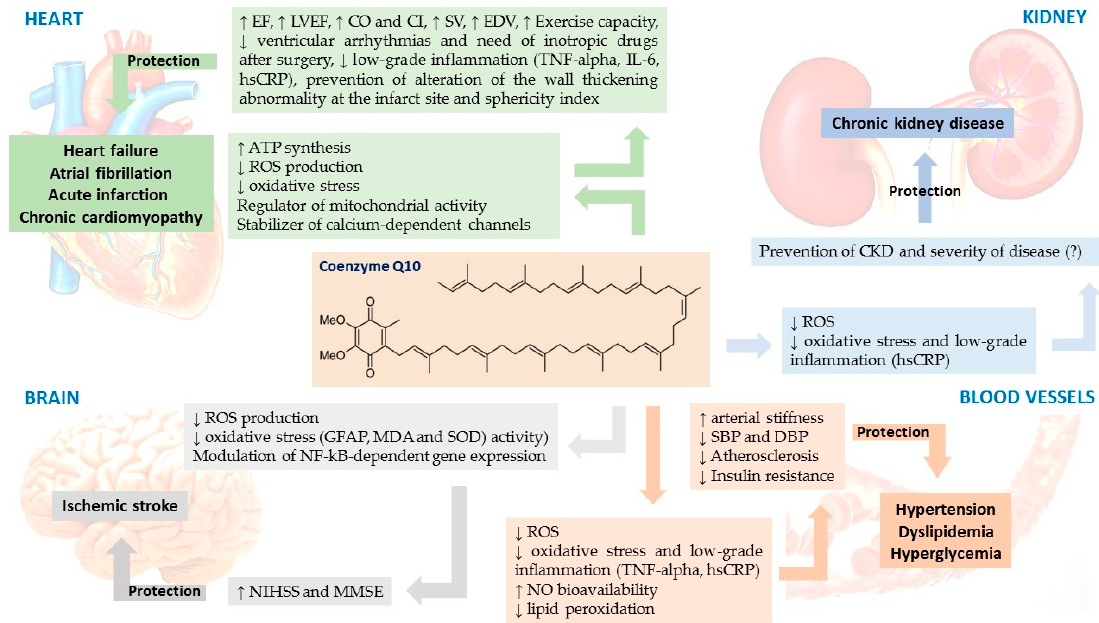
Figure 2. Involvement of CoQ 10 deficiency and cardiovascular disease risk factors. ATP: adenosine triphosphate; CI: cardiac input; CO: cardiac output; CKD: chronic kidney disease; DBP: diastolic blood pressure; EDV: end-diastolic volume; EF: ejection fraction; GFAP: glial fibrillary acidic protein; hs-CRP: high sensible- C reactive protein; IL-6: interleukin-6; LVEF: left ventricular ejection fraction; MDA: malondialdehyde; MMSE: mini mental state examination; NIHSS: national institute of health stroke scale; NO: nitric oxide; NF-kB: nuclear factor kappa B; ROS: reactive oxygen species; SBP: systolic blood pressure; SOD: superoxide dismutase; SV: stroke volume; TNF-alpha: tumor necrosis factor-alpha.